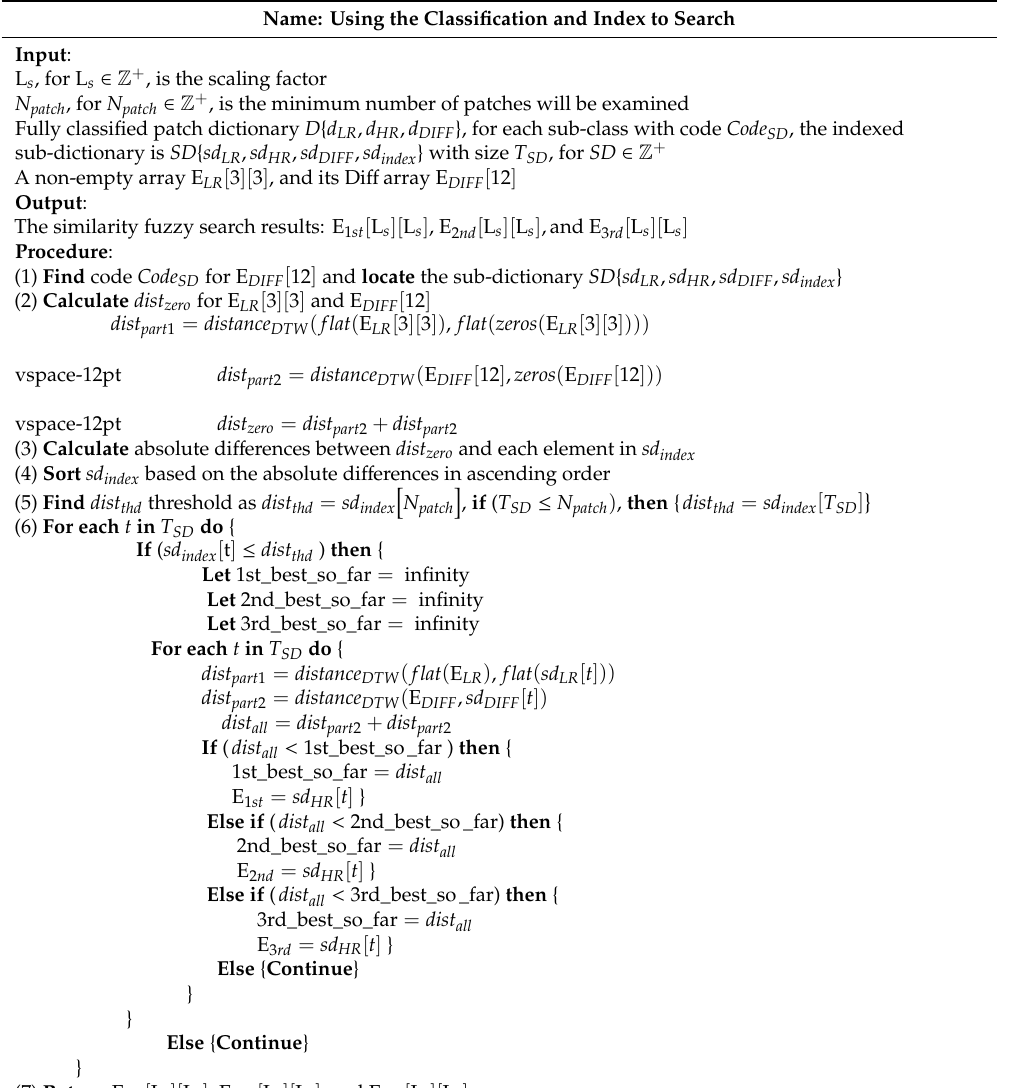
Table 8. The similarity search algorithm based on dictionary classification and the index. Name: Using the Classification and Index to